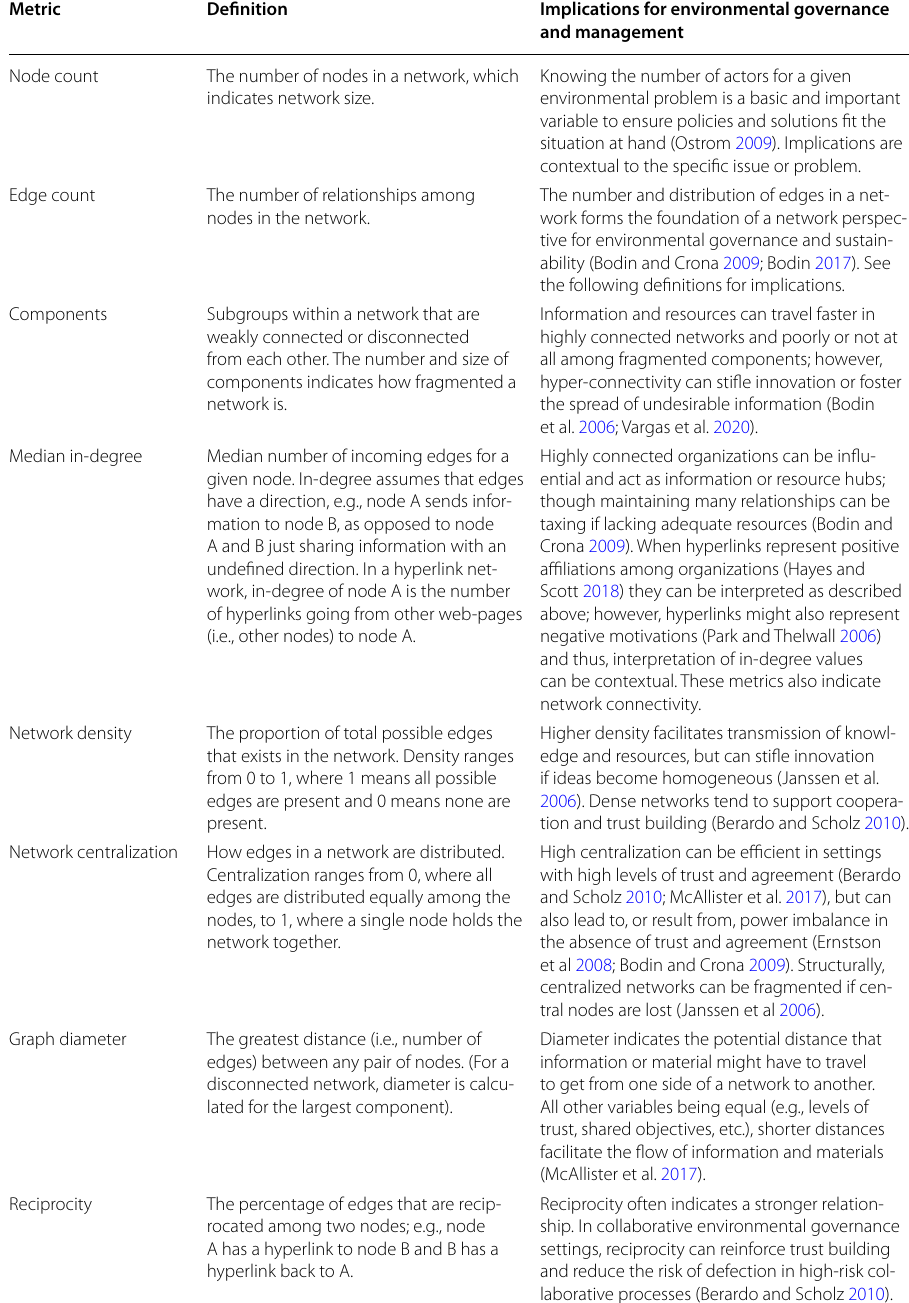
Table 1 Definition of several social network metrics that are commonly used in SNA studies about environmental issues and what the metrics imply for environmental governance and management and the use of online hyperlink